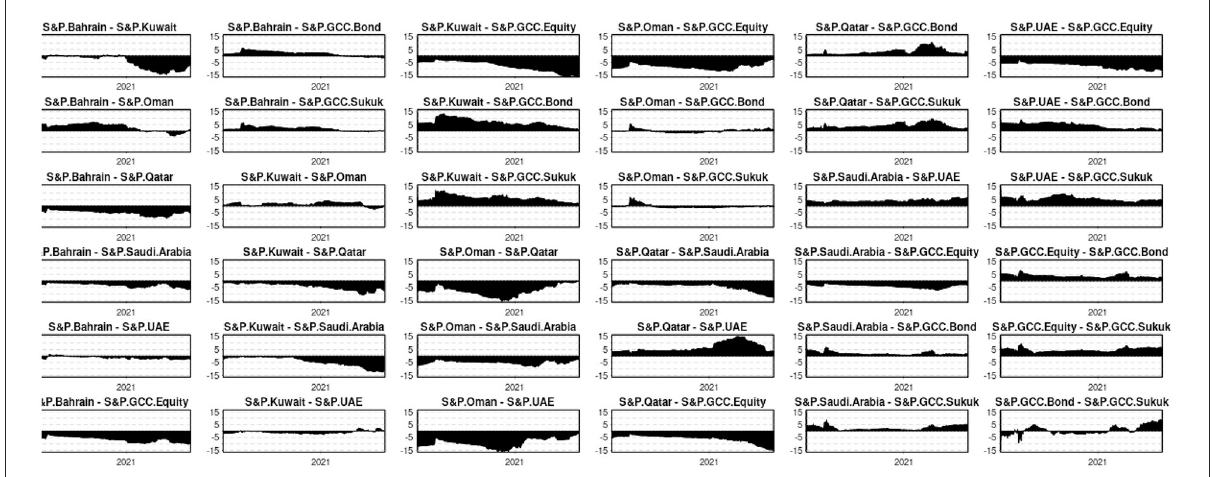
FIGURE5 Dynamic net pairwise total directional connectedness. The of TVP-VAR approach with lag-length of order one by (BIC) criterion and a 20-step-ahead generalized forecast error variance decomposition (FEVD) are provided in the this figure. The filled area represents the net total directional connectedness. The positive values indicate the net transmitter role and negative values indicate the net receiving role of financial market indices.